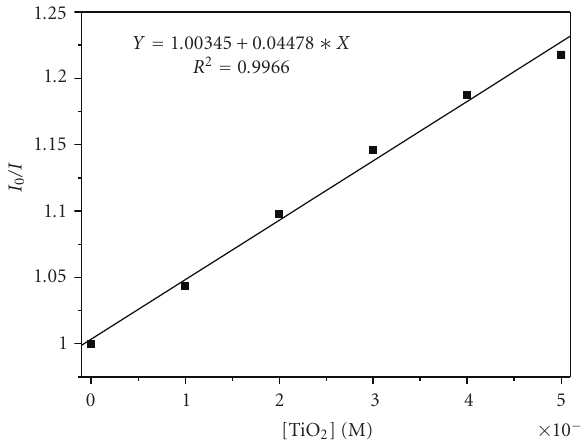
Figure 4: Stern-Volmer plot for the fluorescence quenching of ZnPP with various concentrations of TiO 2 (0–5) × 10 − 4 M in water.